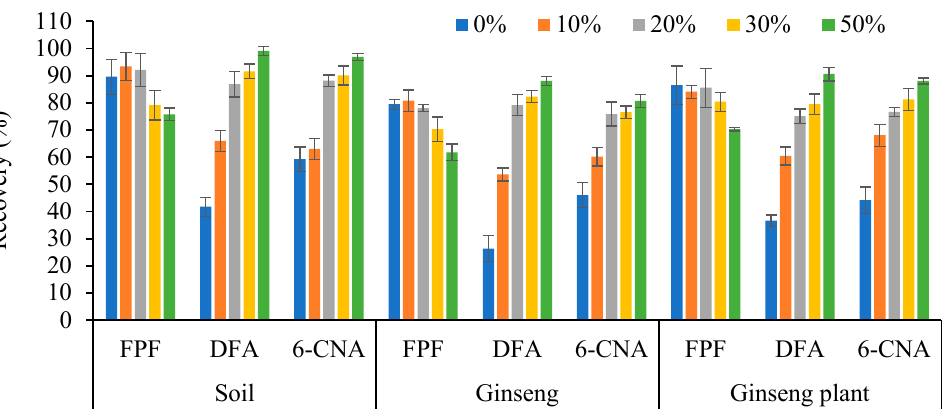
Figure 1. Recovery of flupyradifurone, difluoroacetic acid, and 6-chloronicotinic acid in soil, fresh ginseng, and ginseng plants for the method using different proportions of water (0–50%) in the extraction solution.